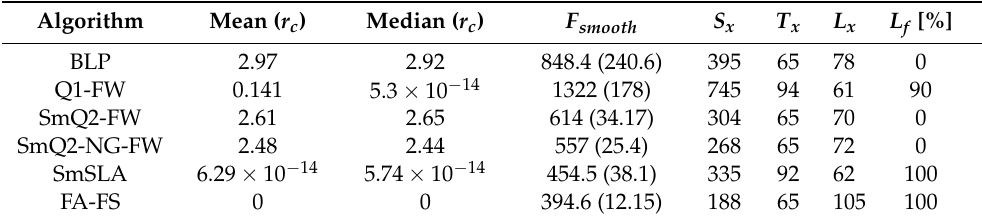
Table 4. Results obtained for the largest farm with 256 ports, 196 EVs, and random charging rates. The maximal number of EVs that can be charged in one time slot is restricted to 80 owing to the power